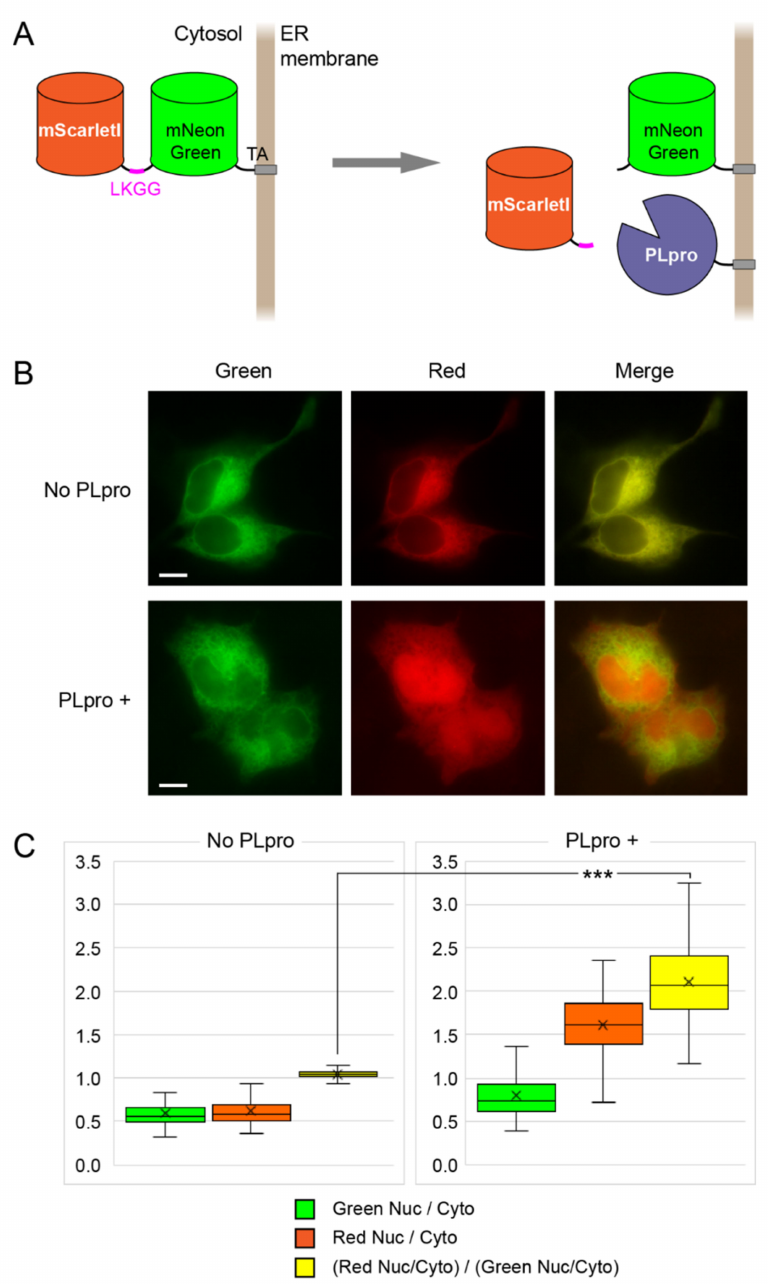
Figure 3. Translocation sensor of PLpro activity. ( A ) Scheme of the sensor consisting of the mScarletI and mNeonGreen fluorescent proteins connected by the linker with LKGG recognition site for PLpro and C-terminal TA localization signal. PLpro-TA (with the same ER-bound localization) cleaves the linker and thus liberates mScarletI from the ER surface. ( B ) Representative examples of cells expressing mScarletI-LKGG-mNeonGreen-TA in the absence (top) or presence (bottom) of PLpro-TA. Images in the green and red channels and their merging are shown. Scale bars: 10 µ m. ( C ) Box and whisker plots for nucleus/cytosol ratios for cells expressing mScarletI-LKGG-mNeonGreen-TA sensor without PLpro (left, n = 190 cells) and in the presence of PLpro (right, n = 150 cells). Median, mean, 1st, and 3rd quartiles as well as minimum and maximum values are shown for each plot. The red and green boxes are the ratio of fluorescence in the nucleus to the cytoplasm in the corresponding channels and the yellow plot is the ratio of the obtained values to each other. ***: p -value less than 0.001 ( t